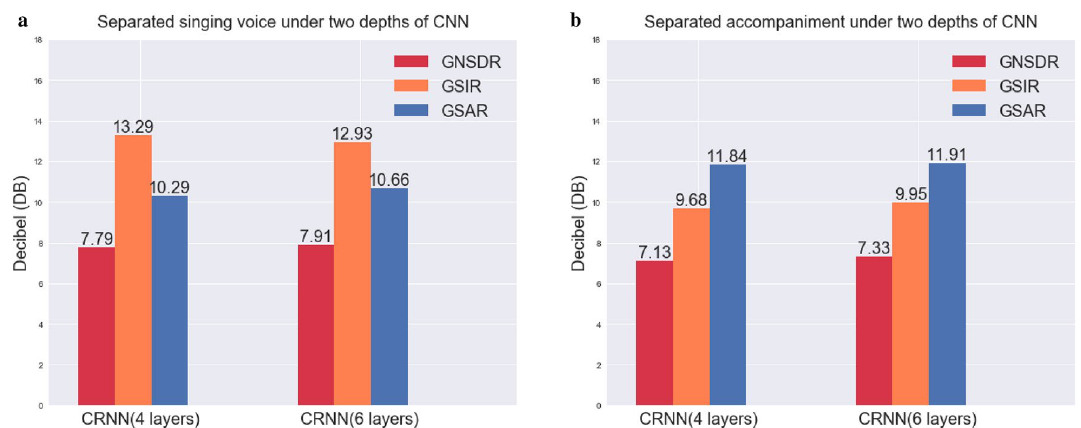
Figure 8. The separation effect of CRNN at different depths, ( a ) is the comparison of the separated singing voice at two depths, ( b ) is the comparison of the separated accompaniment at two